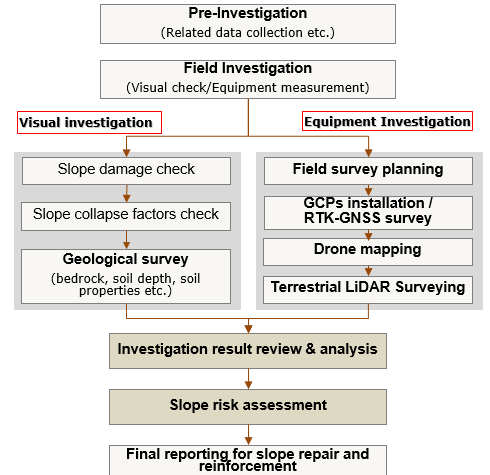
Figure 3. Work flow of slope risk assessment